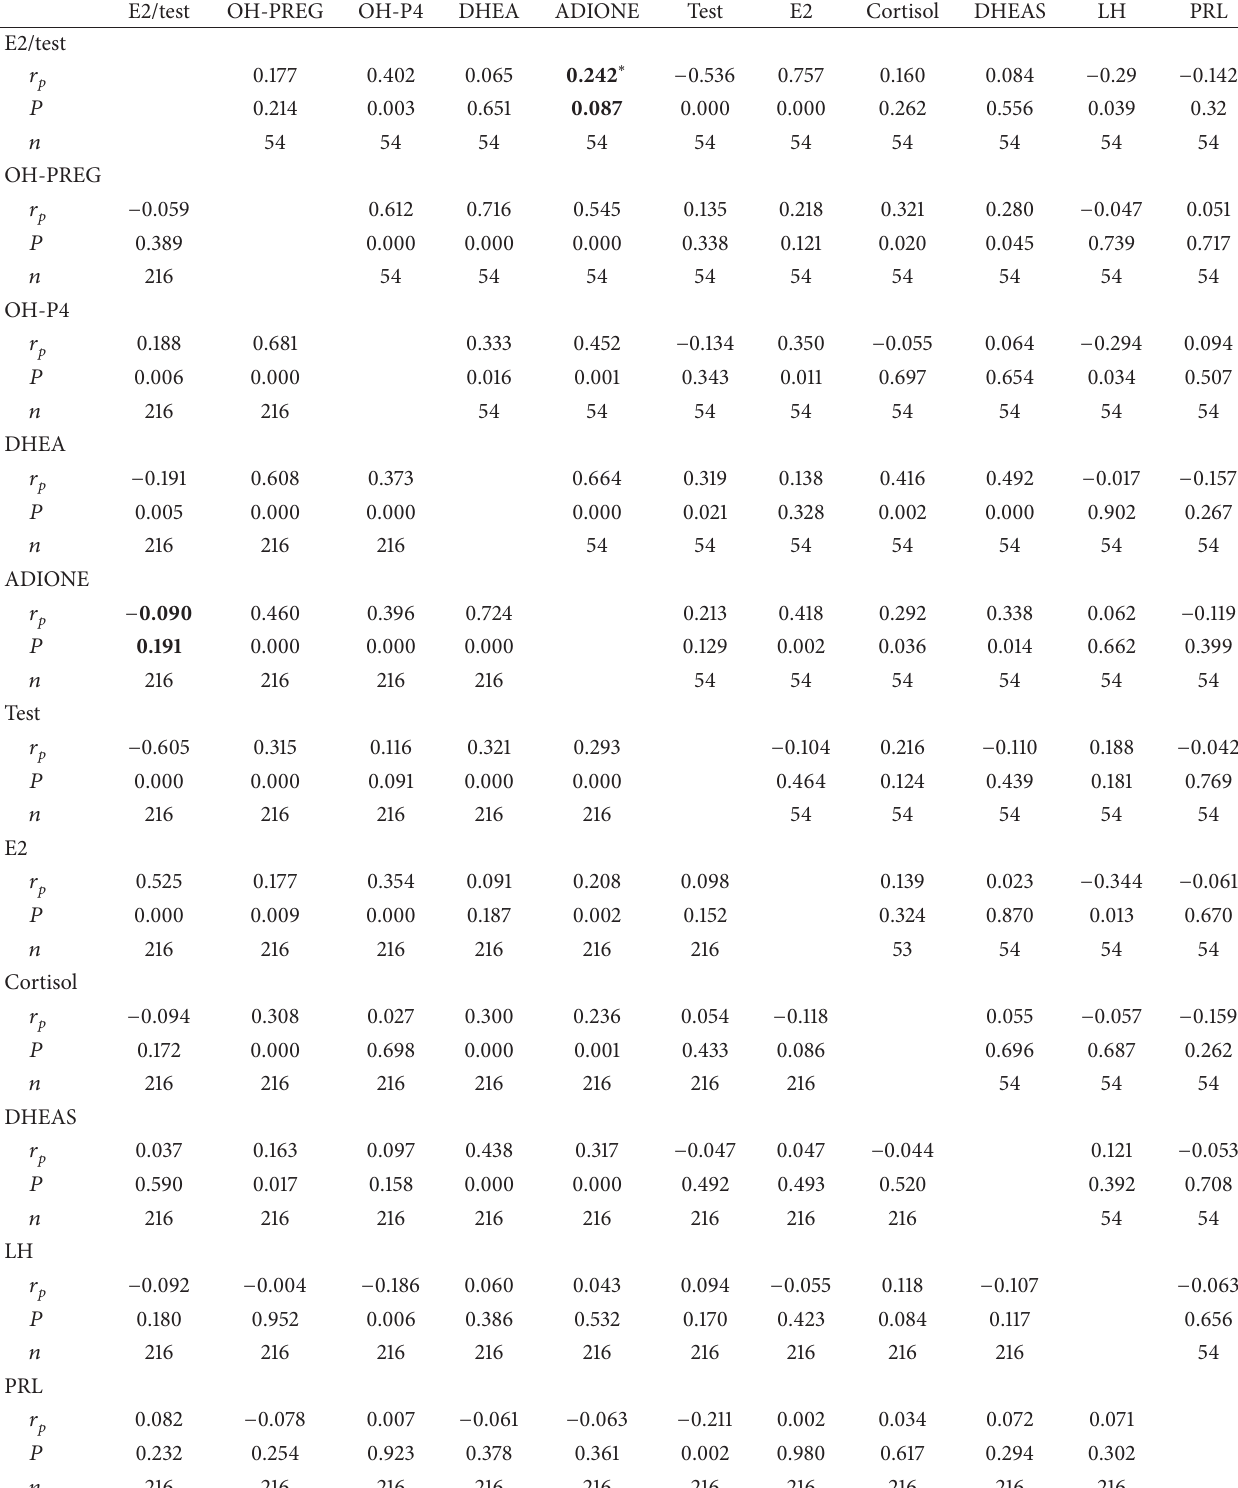
Table 4: Age- and sex-adjusted correlations for total pre-RA (top) and CN (bottom) log values (imputed in